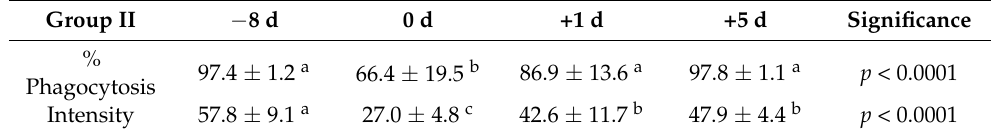
Table 2. Values representing the mean and the standard deviation of the percentage of cells that underwent phagocytosis and its intensity, with blood samples from group I (1 to 15) at times − 11 d, 0 d, +1 d, +2 d, and +3 d. Statistical difference according to the Tukey–Kramer test—Beltsville, 2003. Group I − 11 d 0 d +1 d +2 d +3 d % Phagocytosis Distinct letters on the same line indicate a significant statistical difference between the results, 0 d = immediately after the race. Table 3. Values representing the average and the standard deviation of the percentage of cells that underwent phagocytosis and their intensity, analyzed with blood samples taken from animals in group II (16 to 30) at moments − 8 d, 0 d, +1 d, and +5 d. Statistical difference according to the Tukey–Kramer test—Beltsville, 2003. Group II